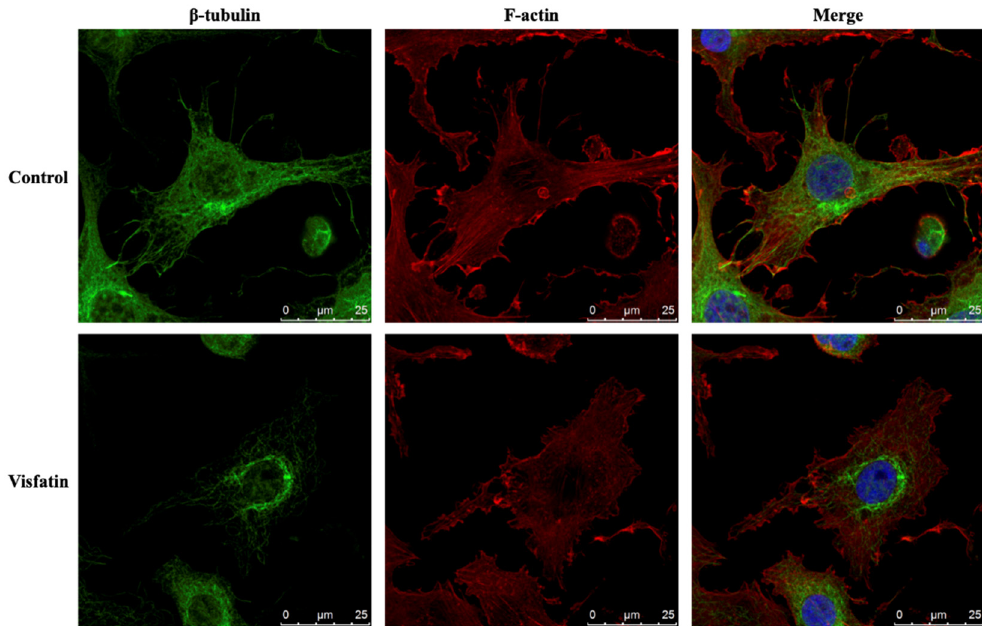
Figure 4. Visfatin destabilizes microfilament and microtubule networks in human primary chondrocytes. Human primary chondrocytes were kept as controls or treated with 5 µ g/mL of visfatin for 4 h. The microfilament and microtubule networks were stained with Alexa Fluor 633-phalloidin (F-actin, red color) and β -tubulin-specific antibody with Alexa Fluor 488-2nd antibody (green color), respectively. The nucleus was stained with DAPI. The fluorescent images were acquired on Leica TCS SP5 II confocal microscope. The scale bar is 25 µ m with 5 µ m intervals.